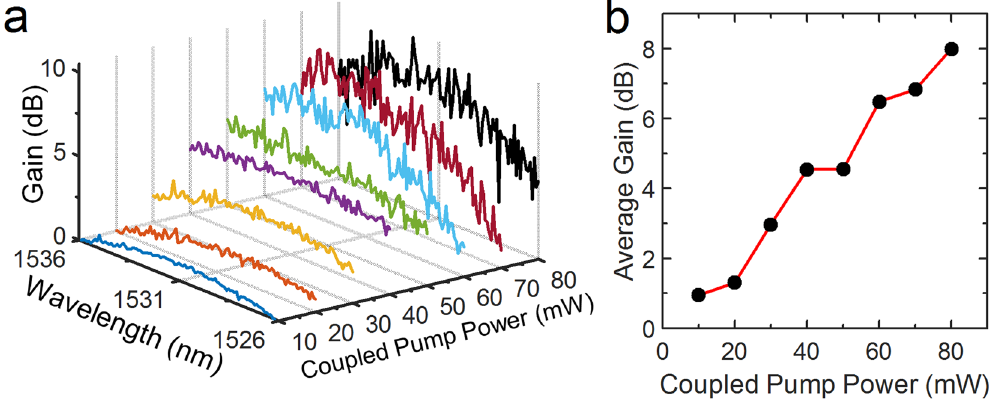
Figure 5. Measured gain performance from our air cladded PWA structures. ( a ) Relationship of gain with respect to wavelength and coupled pump power, and ( b ) Relationship of average gain with respect to coupled pump